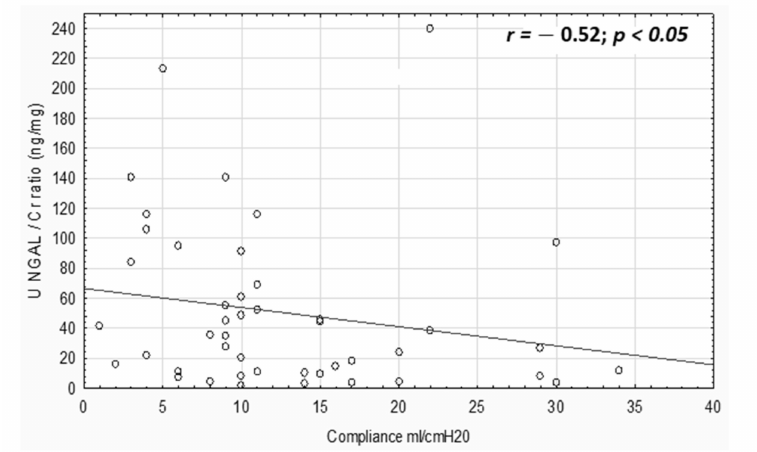
Figure 2. Correlation between uNGAL/Cr ratio and bladder compliance. Table 3. Comparison between HS